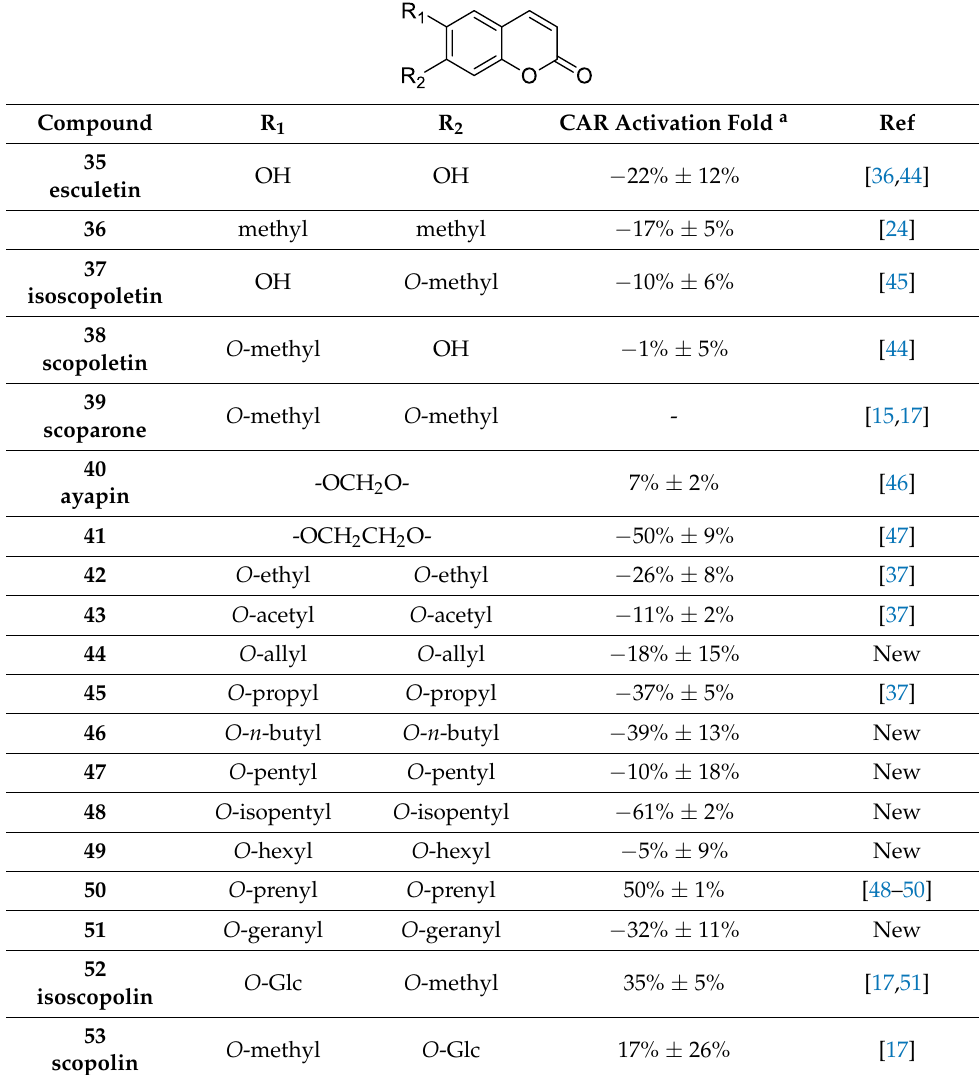
Table 2. Di-substituted coumarins and their CAR activation.